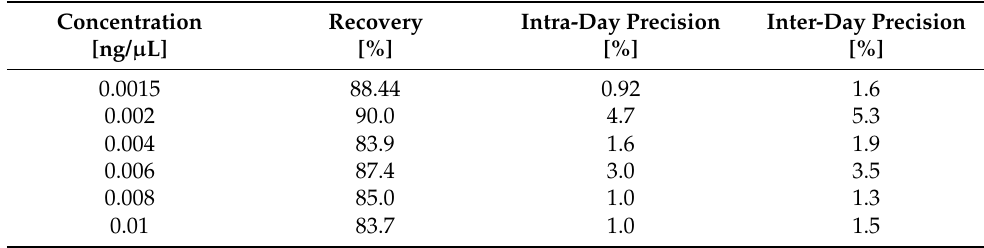
Table 1. Recoveries of EGDN at various concentration levels with corresponding relative standard deviation of intra-day and inter-day precision.